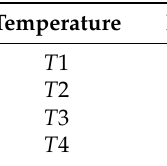
Table 3. Pt-100 sensors heights in the test